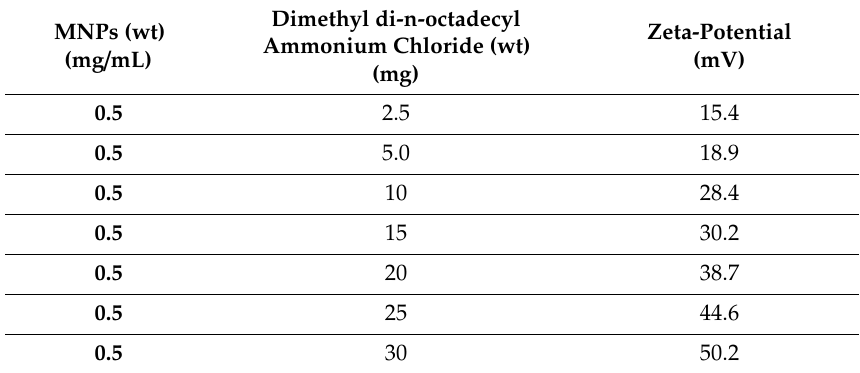
Table 2. StabilityofFe 3 O 4 @SiO 2 -NH 2